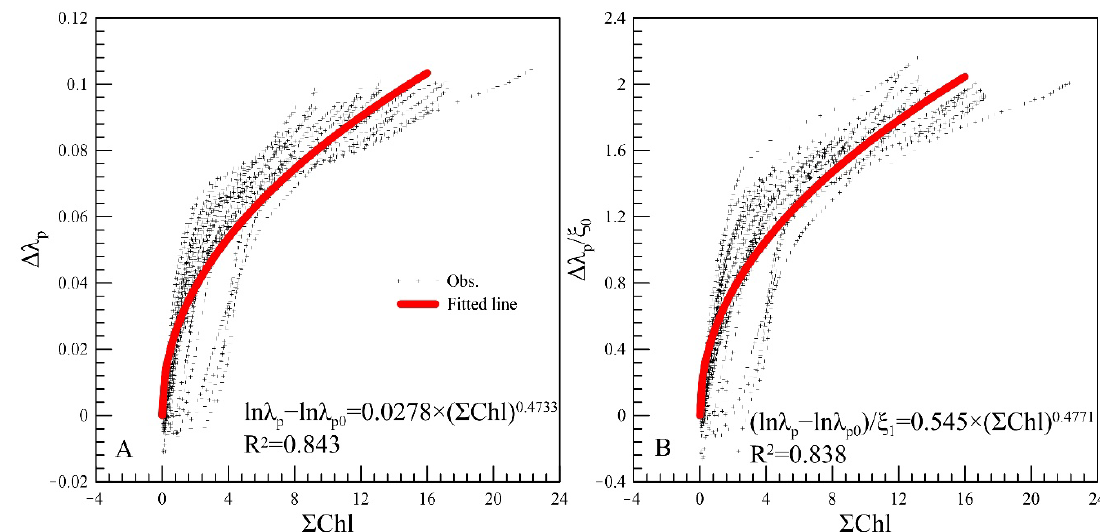
(relative to the ideal in pure sea- 𝜆𝜆 𝑝𝑝 𝜆𝜆 𝑝𝑝0